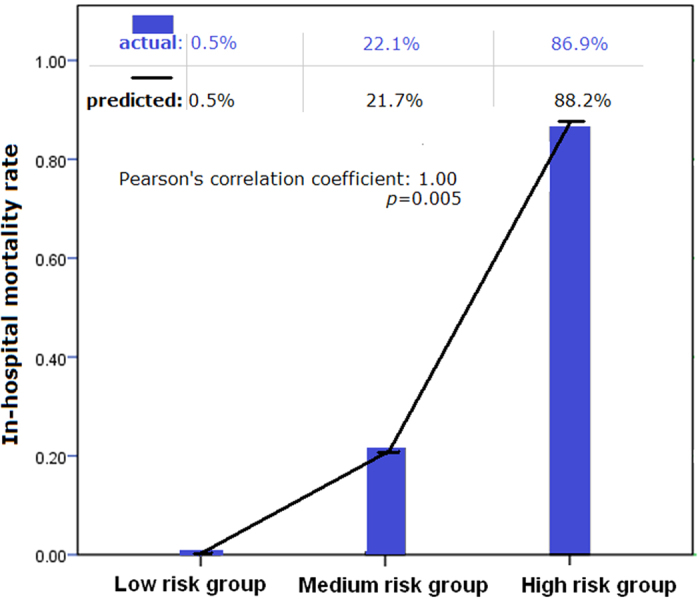
Comparison between the actual in-hospital mortality and the in-hospital mortality predicted by the NT-pro BNP-based scores in hospitalized HF patient.Note: The actual in-hospital mortality rates (bar) and the predicted morality rates (dotted line) had highly significant correlation (Pearson’s correlation coefficient = 1.00; p = 0.005).